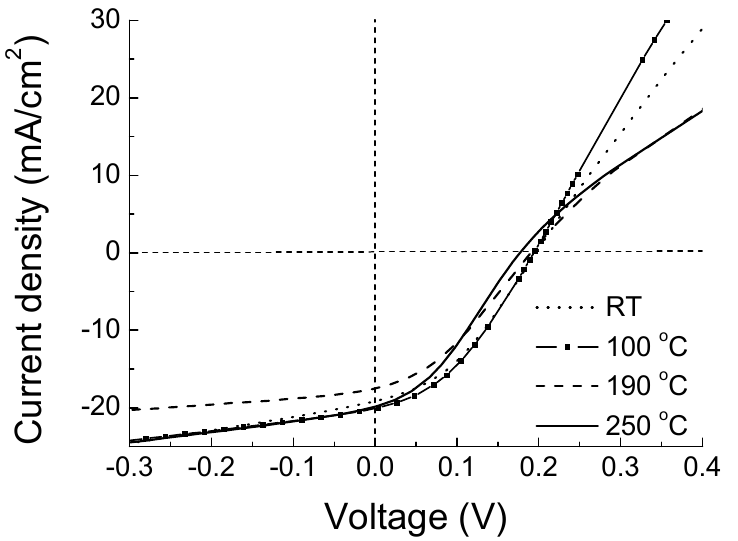
Figure 6. J ‐ V characteristics measured under illumination of the photocells fabricated with ITO thin films fabricated at different substrate temperature. Table 3. Main electrical parameters of the ITO films deposited at 25 W and 0.17 Pa as function of the substrate temperature. The nature of the films and the V OC of the photocells are also included. T substrate ( ◦ C)